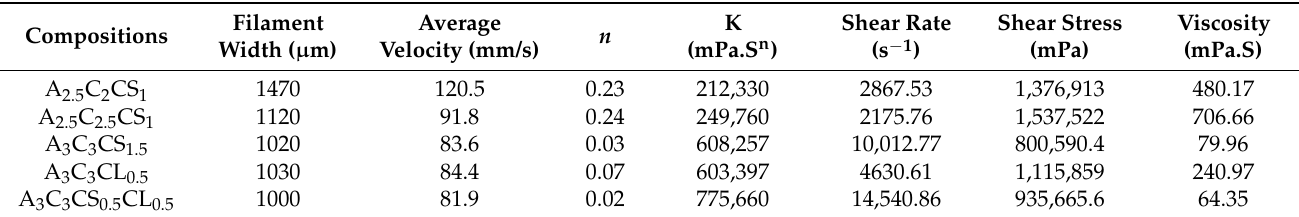
Table 4. Shear-thinning co-efficient ( n and k) and shear rates during extrusion and corresponding shear stresses and